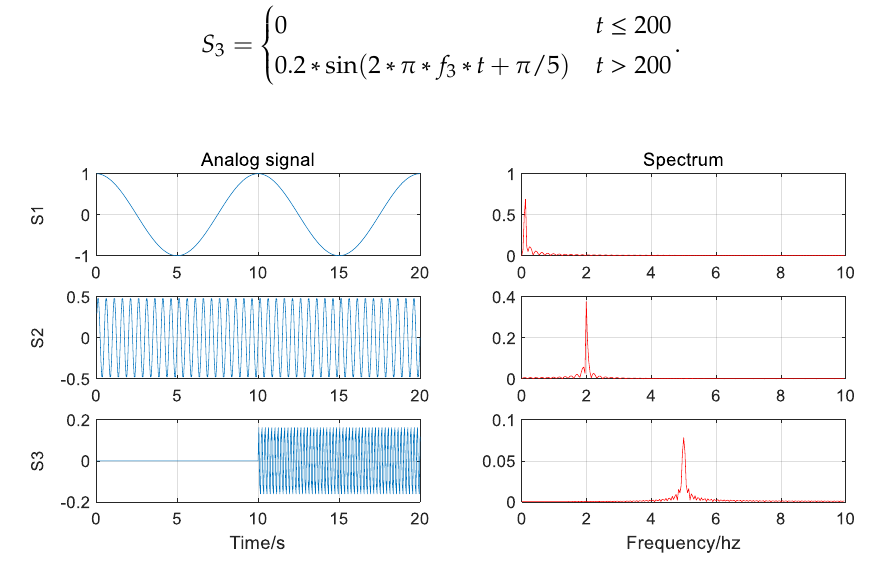
Figure 7. Signal waveform and corresponding spectrogram (with discontinuous signal).